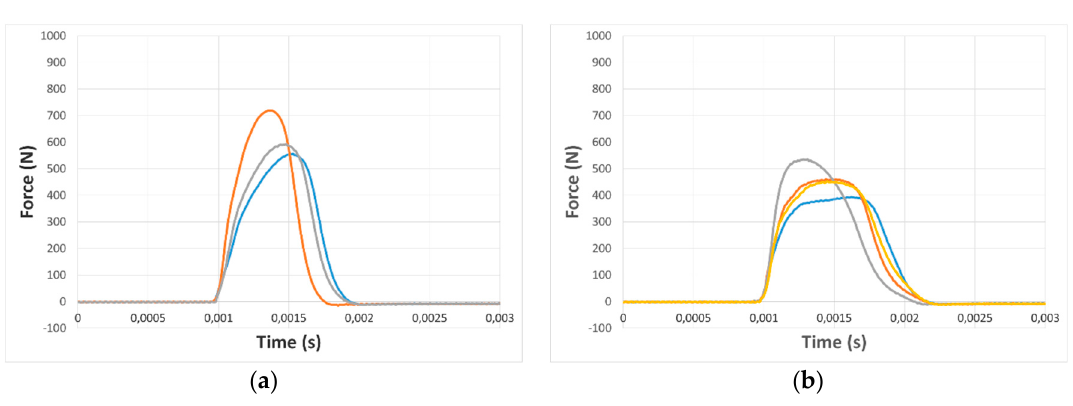
Figure 13. Impact test on Giunta room vault: force–time curve of ( a ) P4 test; ( b ) P15 test. Table 3. Results of impact test on Giunta room